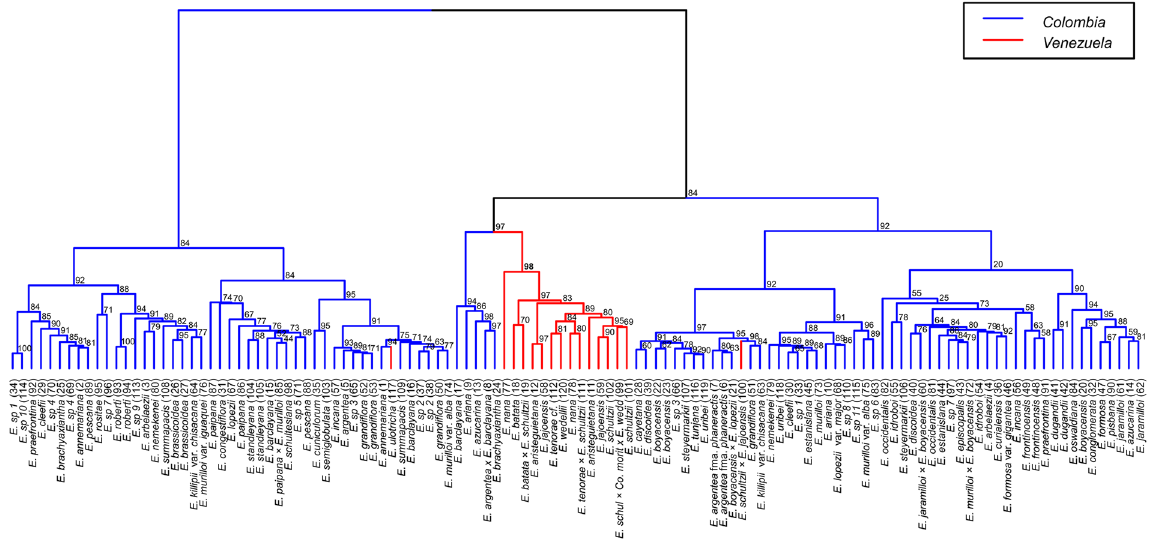
Figure 2. HCAbp based on metabolic fingerprinting in negative ionization mode of 120 plant samples of the genus Espeletia analyzed by